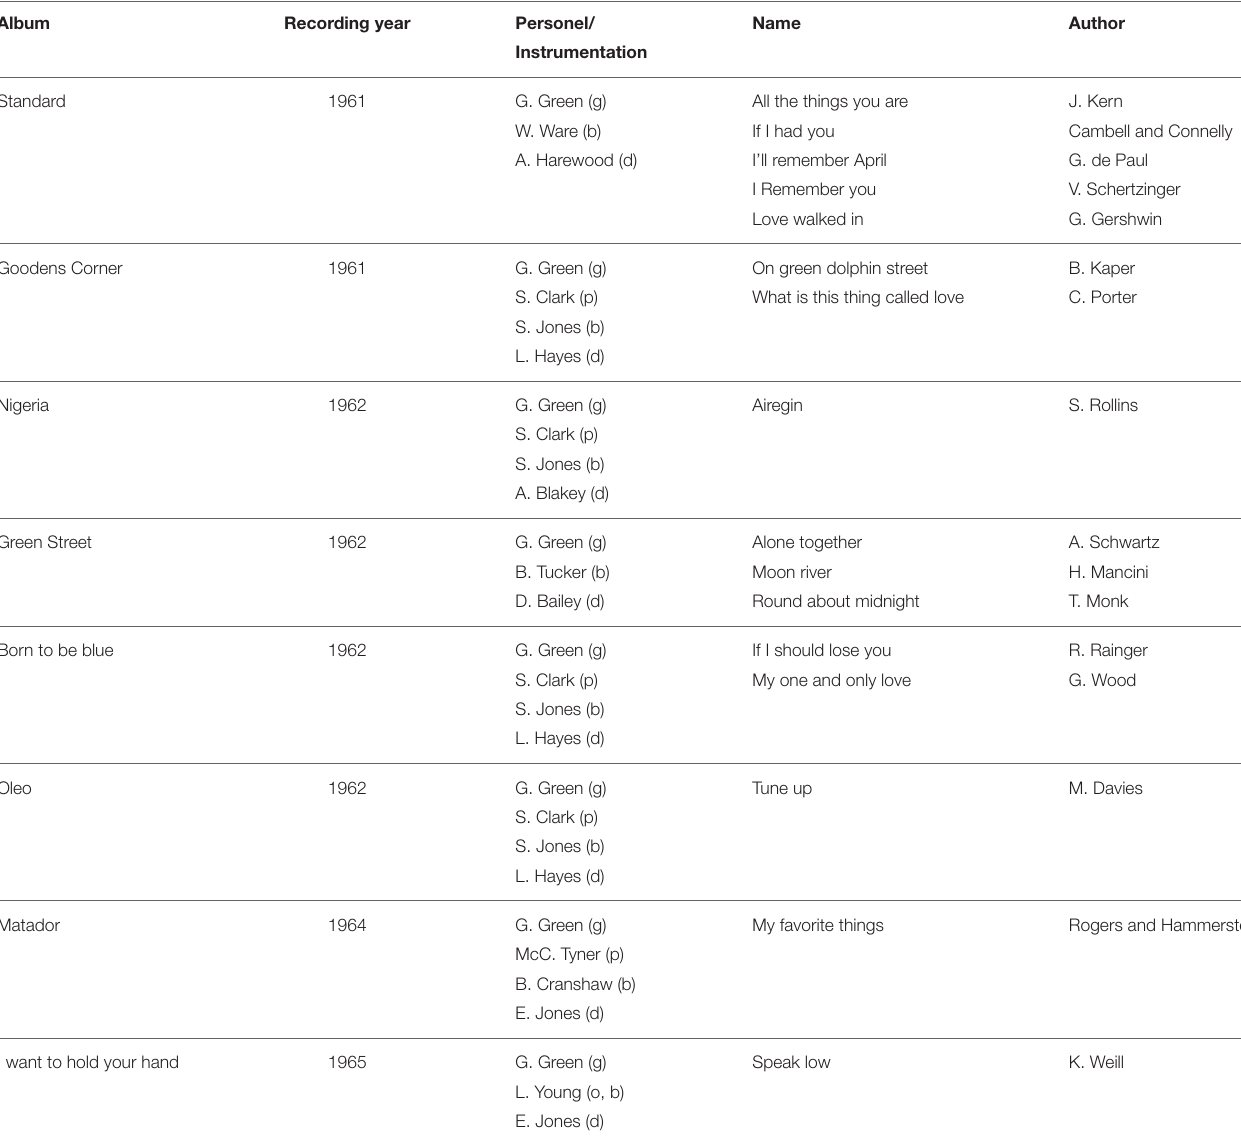
TABLE 1 | Recordings list containing album, recording year, instrumentation (g, guitar; p, piano; b, double bass; and d, drums), piece name, and